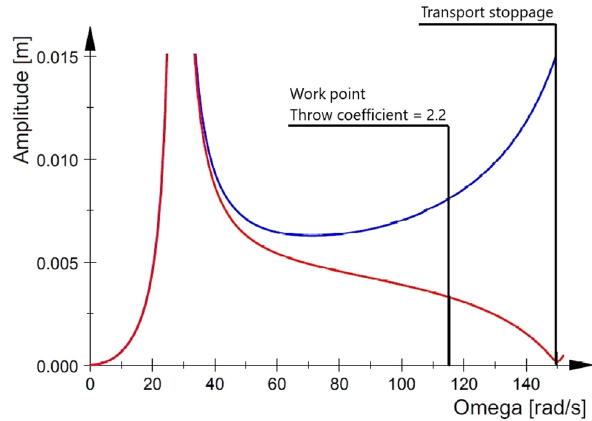
Figure 3: Amplitudes of the trough ( red line ) and the eliminator ( blue line ) as a function of the excitation frequency, for the strategy of operating before the antiresonance.